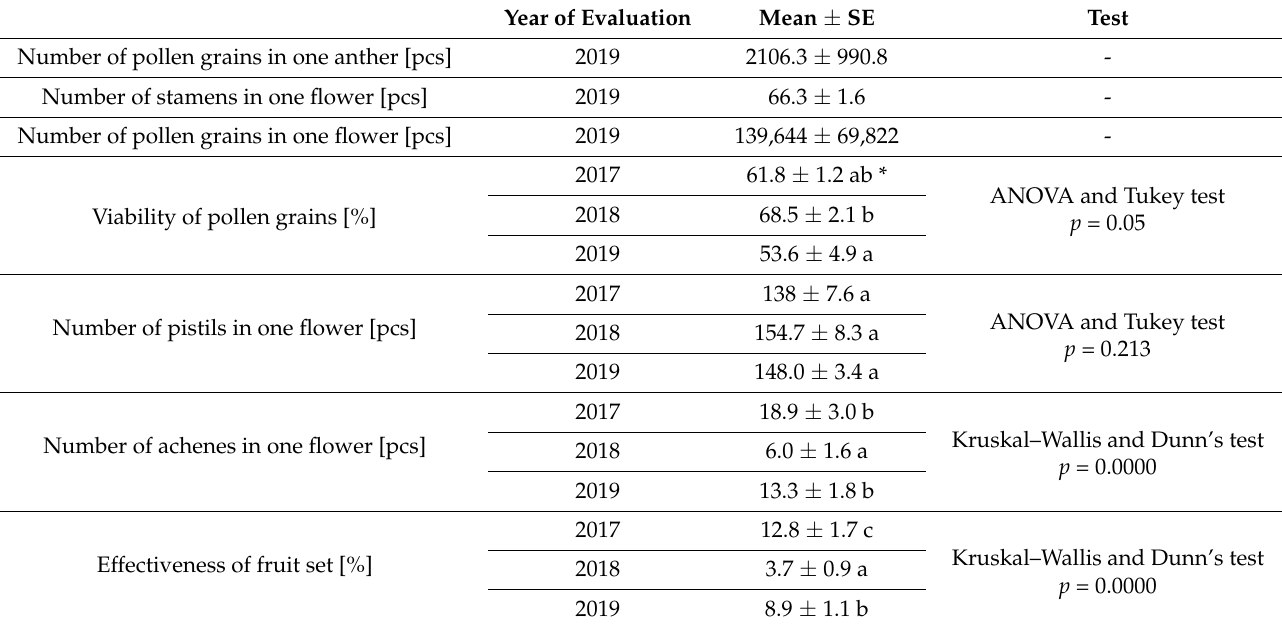
Table 5. The production and viability of pollen and efficiency of fruit setting of Ranunculus illyricus .